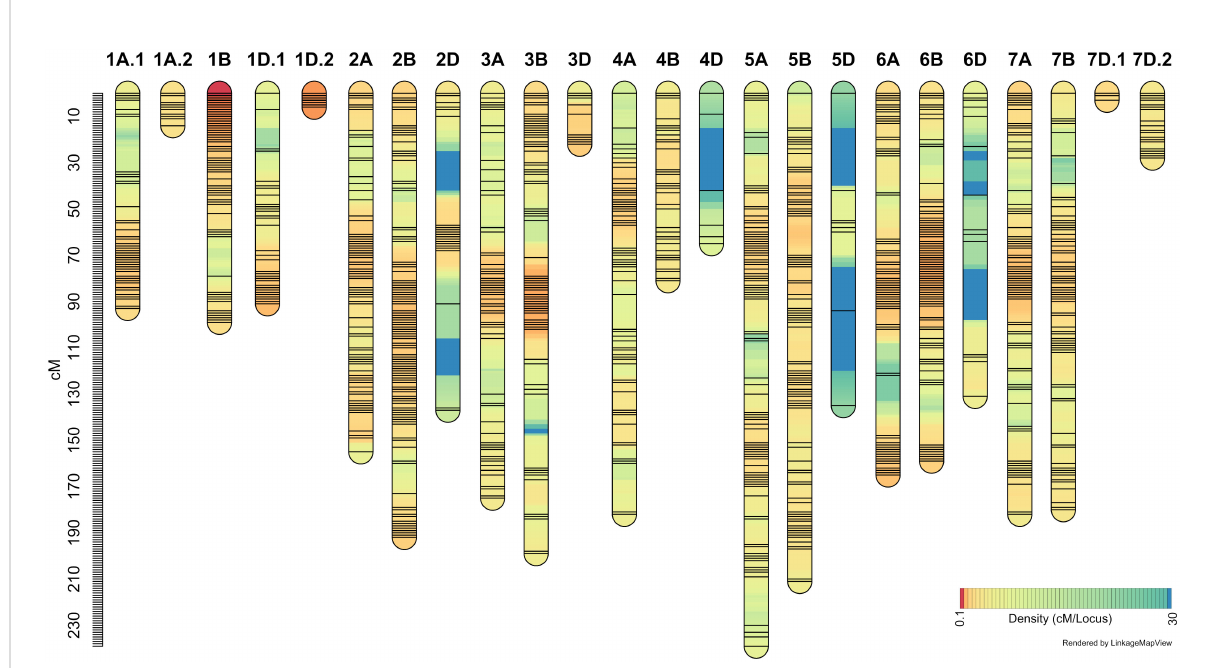
FIGURE 4 ‘ Sadash/P2711 ’ linkage map constructed using single nucleotide polymorphism (SNP) markers from 15K wheat SNP